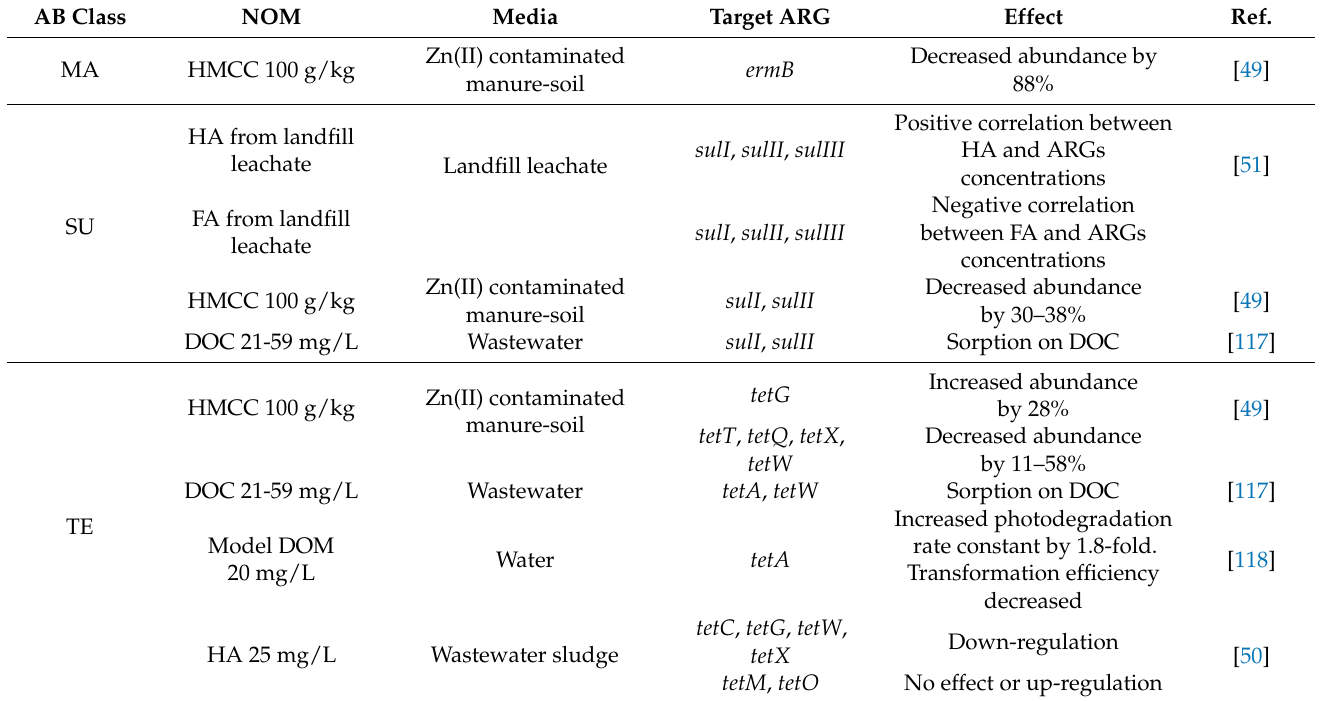
Table 7. The main effects of HS and NOM of the dissemination of antibiotic